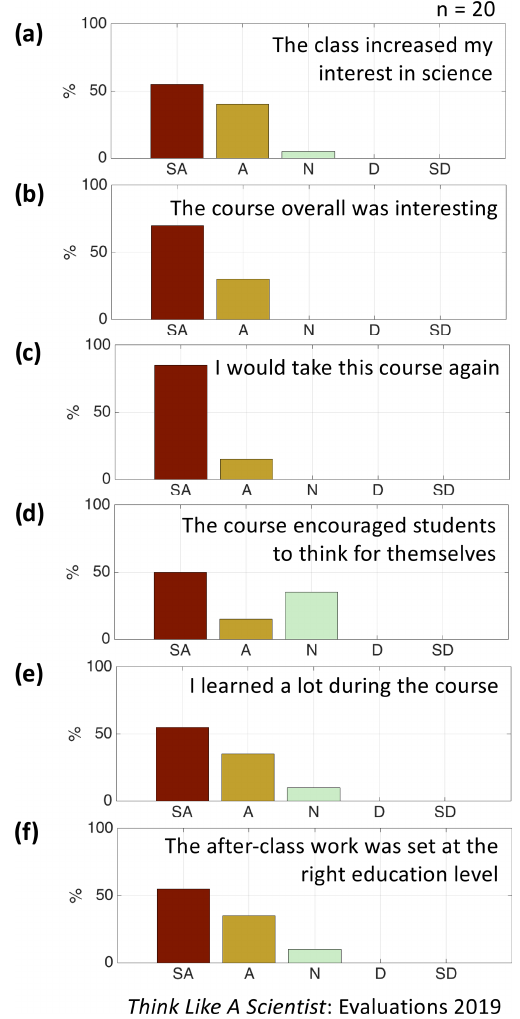
Figure 3. Student feedback on selected post-course questions. Full feedback from three courses are provided in the Supplement along- side pre- and post-course student questionnaire templates. Abbrevi- ations stand for Strongly Agree (SA), Agree (A), Neutral (N), Dis- agree (D), and Strongly Disagree